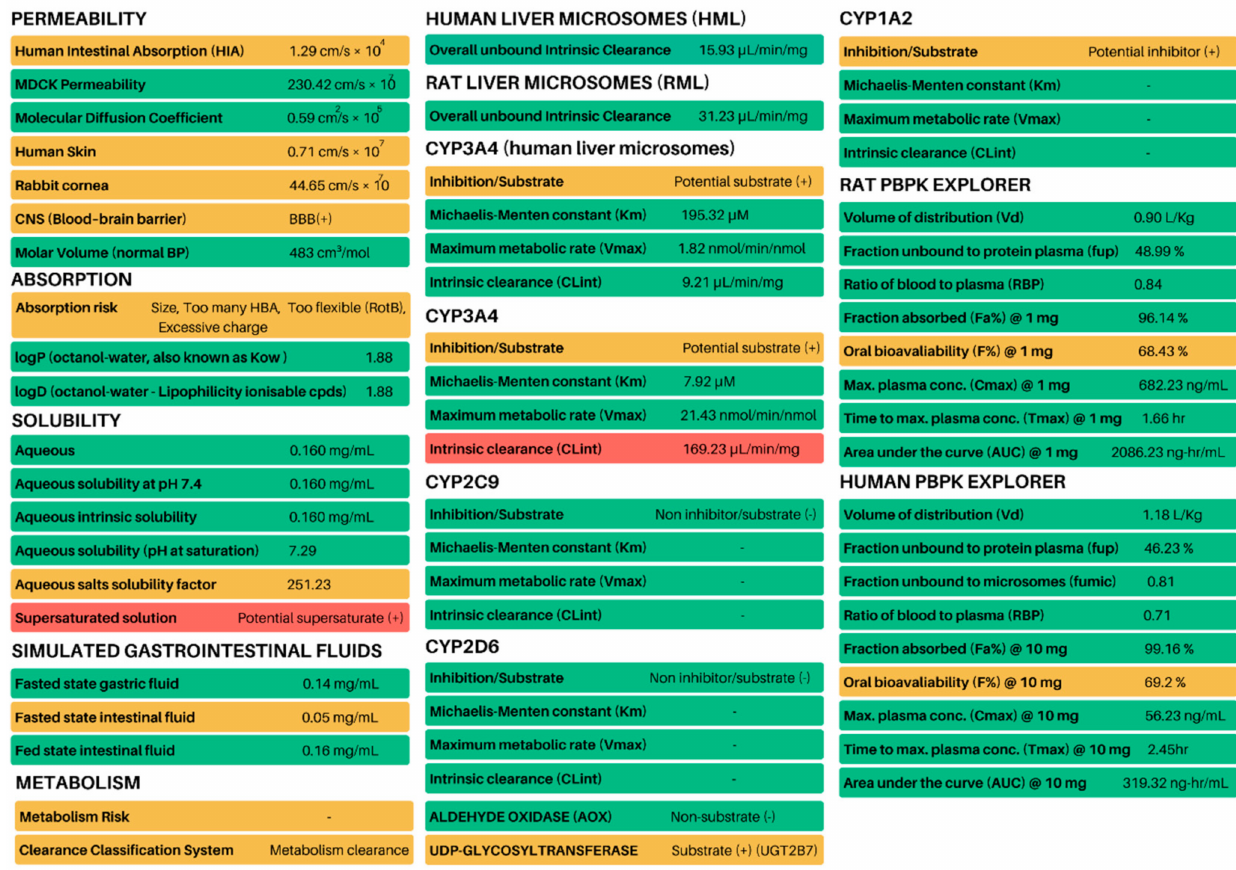
Figure 5. ADME and PBPK multiparametric prediction of LDT-597 using the Detoxie ® software (http://insilicall.com/, accessed on 17 December